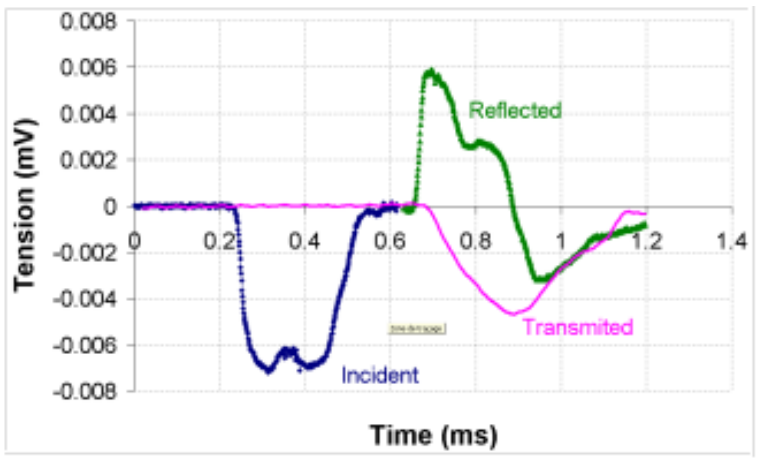
Figure 3. Example of incident, reflected, and transmitted pulse, p = 0.9 bar (831 s − 1 ). The incident, transmitted and the striker bars were modelled as an isotropic elastic material. Meanwhile, the specimen was a standard size of 13 × 13 × 13 mm 3 and was modelled with an orthotropic elastic material. This composite specimen is made up of 40 stacked plies with a ply thickness of 0.325 mm. An assembly containing all parts (bars, striker, and specimen) was modelled using three-dimensional solid 8-node linear brick elements, with reduced integration and hourglass control (C3D8R in ABAQUS library). The incident and transmitted pulses and the striker bars had uniform mesh with 104,192, 97,870, and 21,890 elements, respectively. The specimen meshed into 8788 elements. The mesh configuration of the composite specimen appears in Figure 4a, while Figure 4b presents detail of the whole model assembly. A surface-to-surface contact is defined at the interfaces of different parts of the SHPB set-up to simulate the interaction at these interfaces, allowing for compressive loads to be transferred between the slave nodes and the master segments. Material properties used in the finite element code are shown in Table 2. The skins with a negligible thickness acting as gauges were placed on the incident and transmitted bars to determine the incident, transmitted and reflected waves. These skins were modelled using the mesh with membrane elements M3D4R (A four-node quadrilateral membrane, reduced integration, hourglass control). Initial velocity conditions were applied to the whole striker volume (all nodes), whose value corresponded to the actual one, e.g., V = 5 m/s. Initial boundary conditions were applied to the striker and the bars such that only movement in one direction was allowed; see Figure